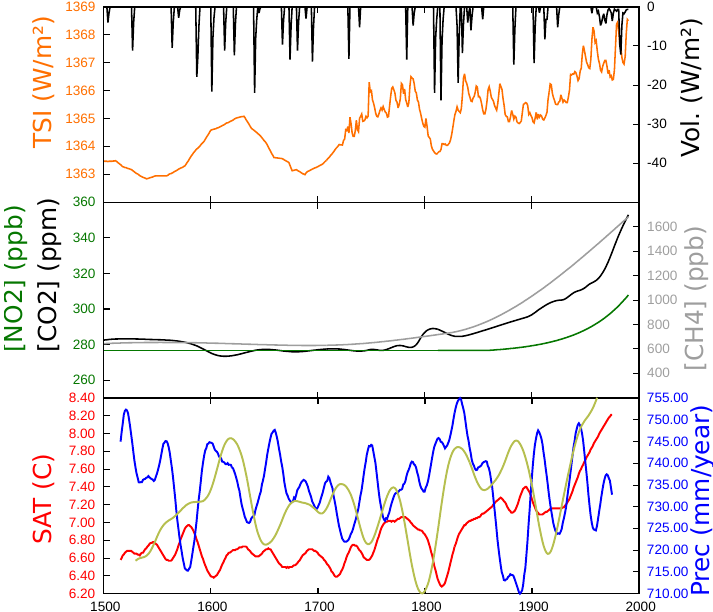
Fig. 1. Three sources of external forcings implemented in the simulation and evolution of spatially averaged SAT (red) and precipitation (blue) over the whole domain in the regional simulation. The NAO index is also represented by dark yellow in arbitrary units. The original annual series in the bottom panel are high-frequency filtered using a Hamming window of 30 time steps. Zorita et al. (2004) described with further details these